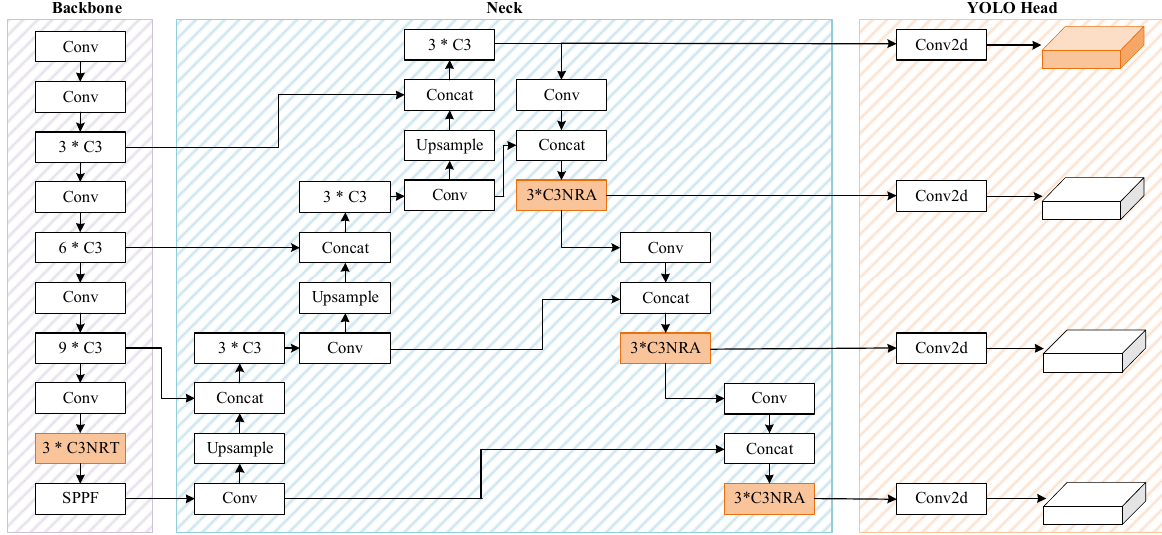
Figure 3. The architecture of the proposed NRT-YOLO.